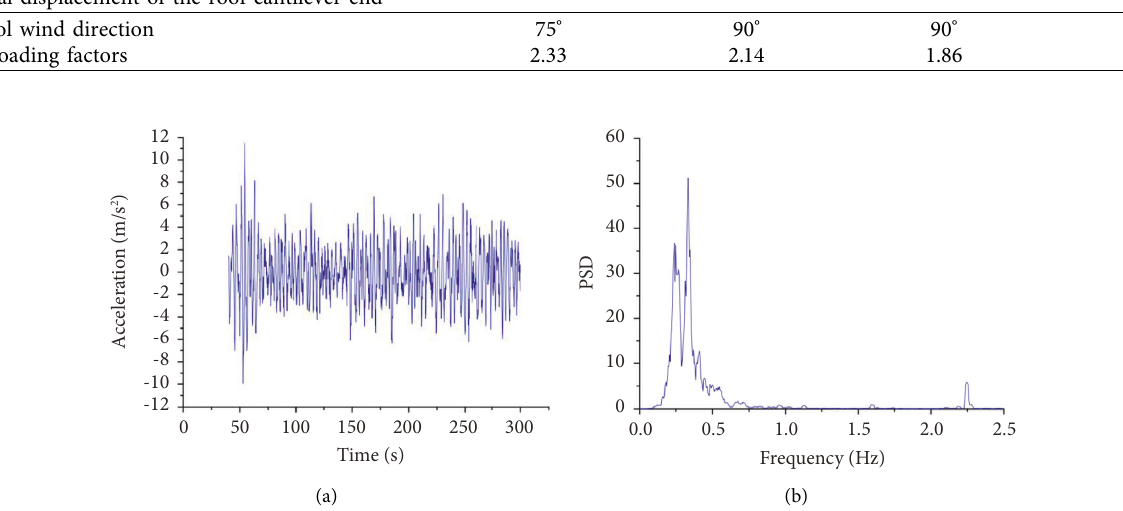
Figure 10: Vertical acceleration at the cantilever end in area D. (a) Acceleration time history and (b) PSD of acceleration.